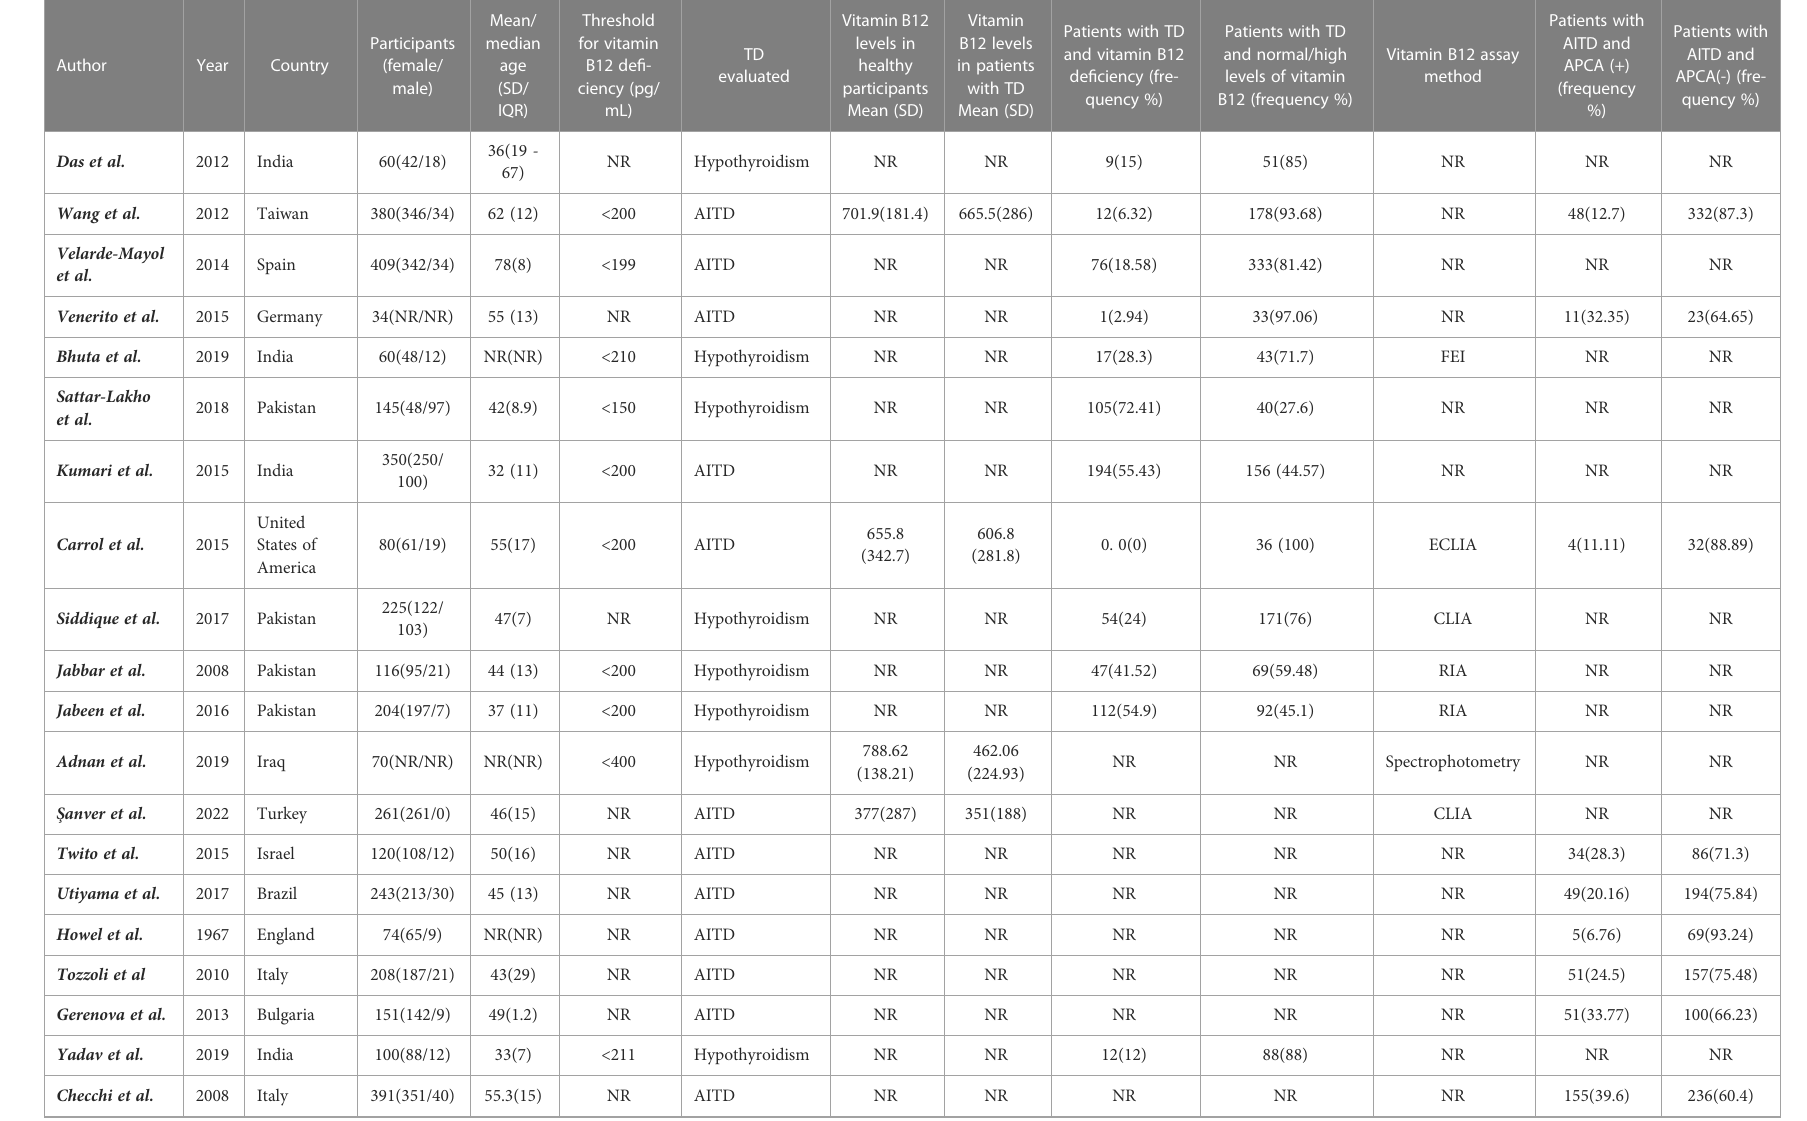
TABLE 1 Characteristics of the studies included in this